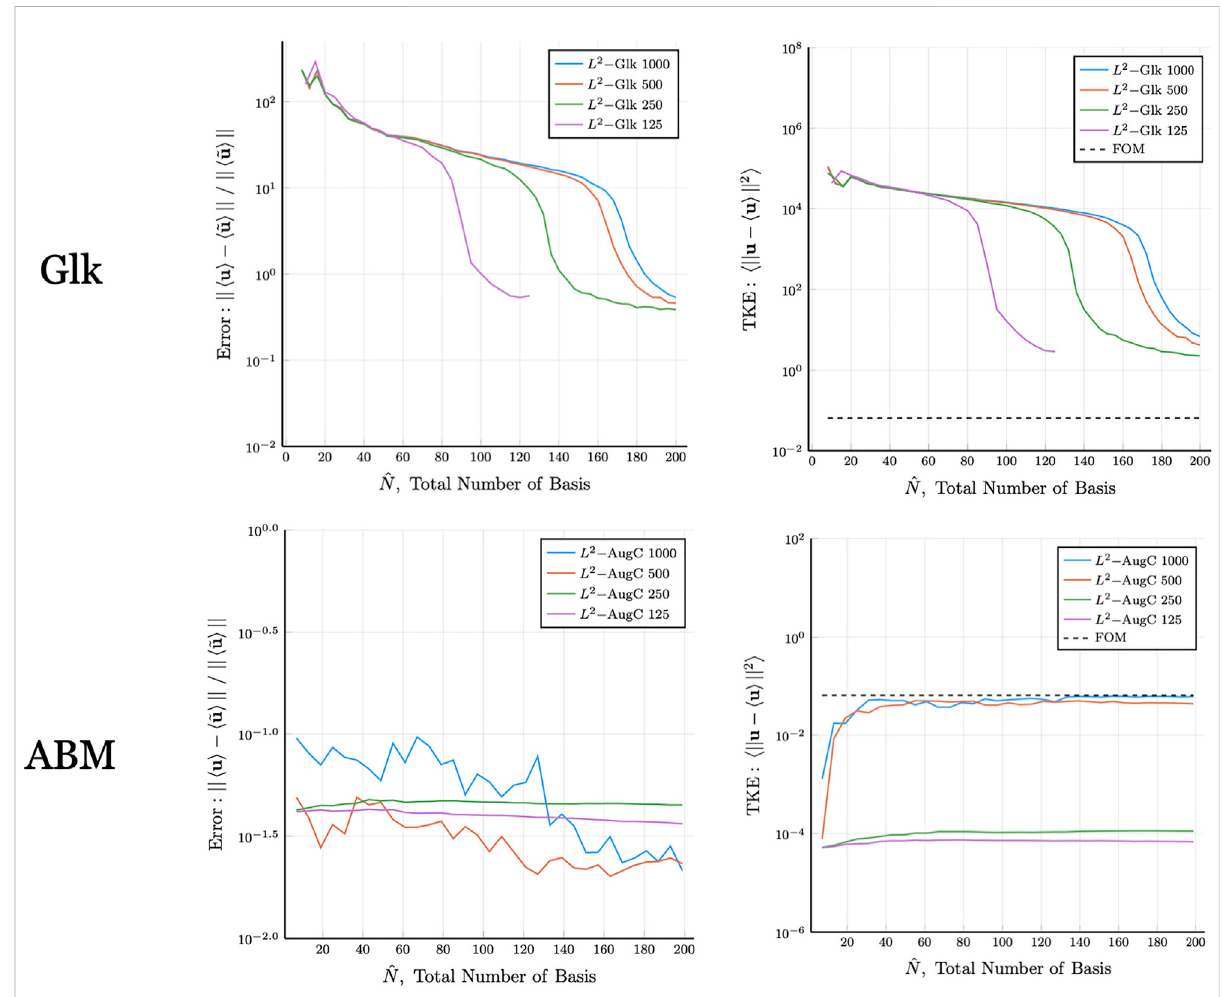
Convergence for mean velocity (left) and TKE (right) for turbulent pipe fl ow at Re = 5300 as a function of the number of modes for the POD- ROM (top) and ABM-ROM (bottom). The dimension of the snapshot space, K , is indicated in the